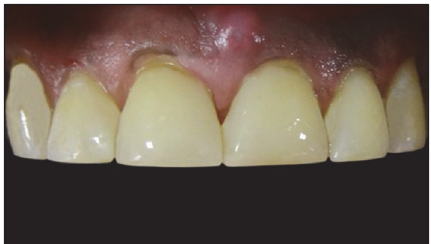
Figure 9: Labial view of upper anterior regions after diastema closure.